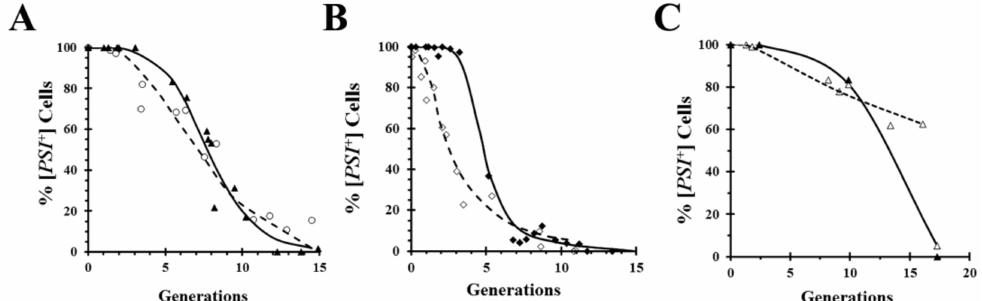
Figure 4. Curing of [ PSI + ] by overexpression of dominant negative Hsp104 mutant and wild-type Hsp104 in di ff erent strains. Curing by overexpression of dominant negative mutant is shown by solid symbols and solid line, while curing by overexpression of wild-type is shown by open symbols and dashed line. ( A ) Comparison of curing by overexpression of dominant negative mutant (from Figure 1A) and wild-type Hsp104 (from Figure 2A) were obtained using relatively strong [ PSI + ] variant in the SY80 yeast strain, a relatively strong variant. ( B ) Comparison of curing by overexpression of dominant negative mutant and wild-type Hsp104 were obtained using the relatively weak [ PSI + ] variant in the L2888 yeast strain from the Liebman laboratory [43]. ( C ) Comparison of curing by overexpression of dominant negative mutant and wild-type Hsp104 were obtained using a relatively strong [ PSI + ] variant in 779-6a yeast expressing red fluorescent protein (RFP)-labeled Sup35 instead of Sup35 from the SUP35 chromosomal